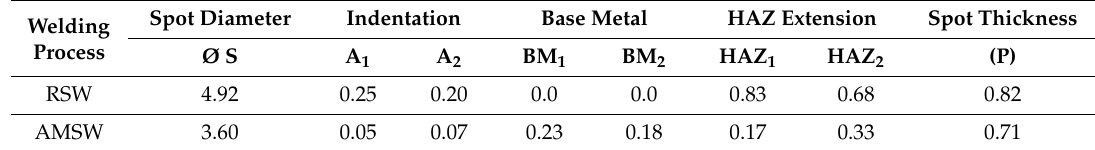
Table 5. Dimensions of the spot-welded joints by the macrography tests (mm).